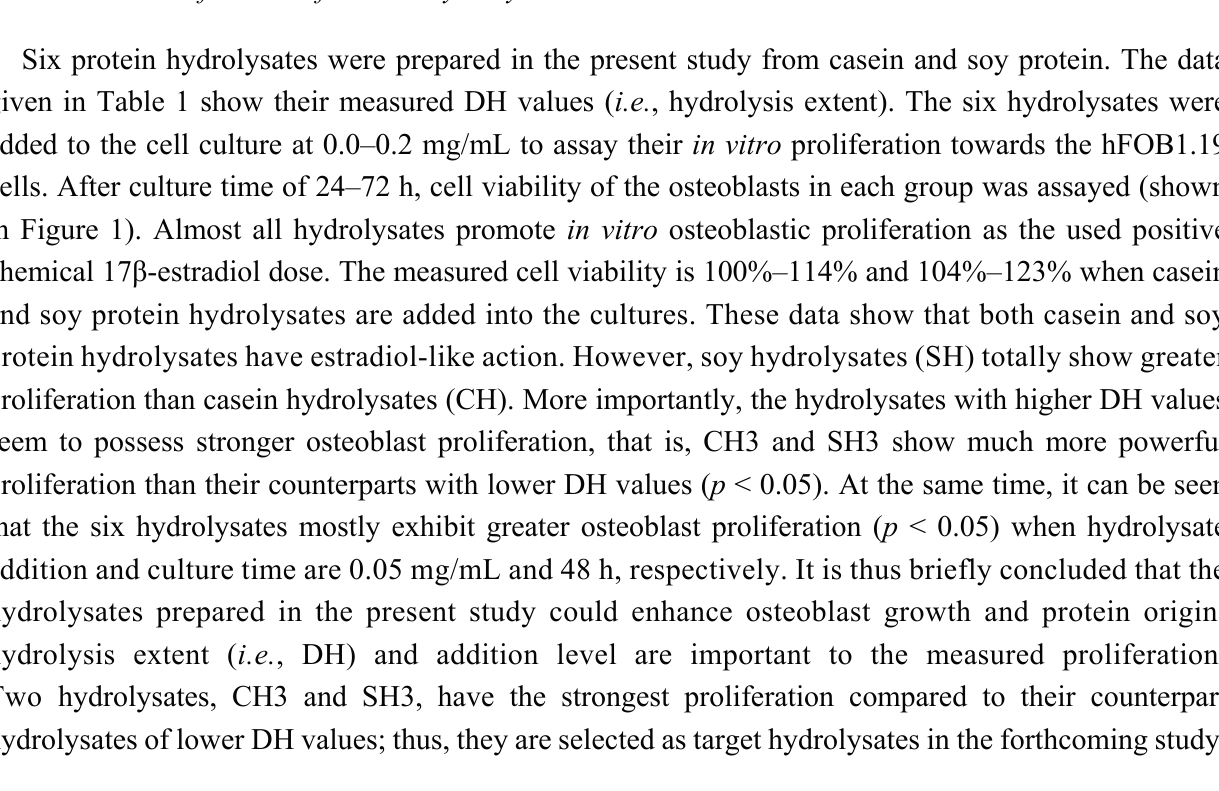
Table 1. Hydrolysis conditions and degrees of hydrolysis (DH) of the prepared six